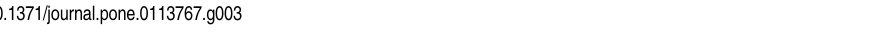
Figure 3. Available methods for SegDecomp. SegDecomp is a custom defined S4 class, containing the measured segregation from